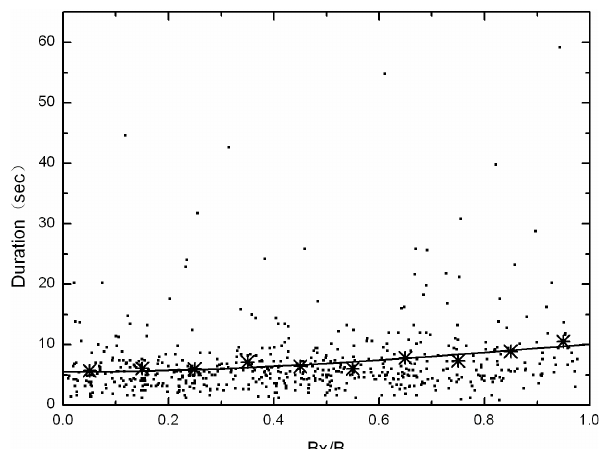
Fig. 3. The relation between scales of the magnetic holes and the orientation of magnetic field deduced from Cluster C1 data. The abscissa represents the value of (cid:12) (cid:14) B (cid:12) (cid:12) B x (cid:12) , where B x is each magnetic holes Length. Small crosses are the 567events se- lected for this study. Asterisks are the medians for each 0.1 bin. The curve fitting are presented based on the (cid:12) (cid:14) B (cid:12) (cid:12) B x (cid:12) bin. The curve